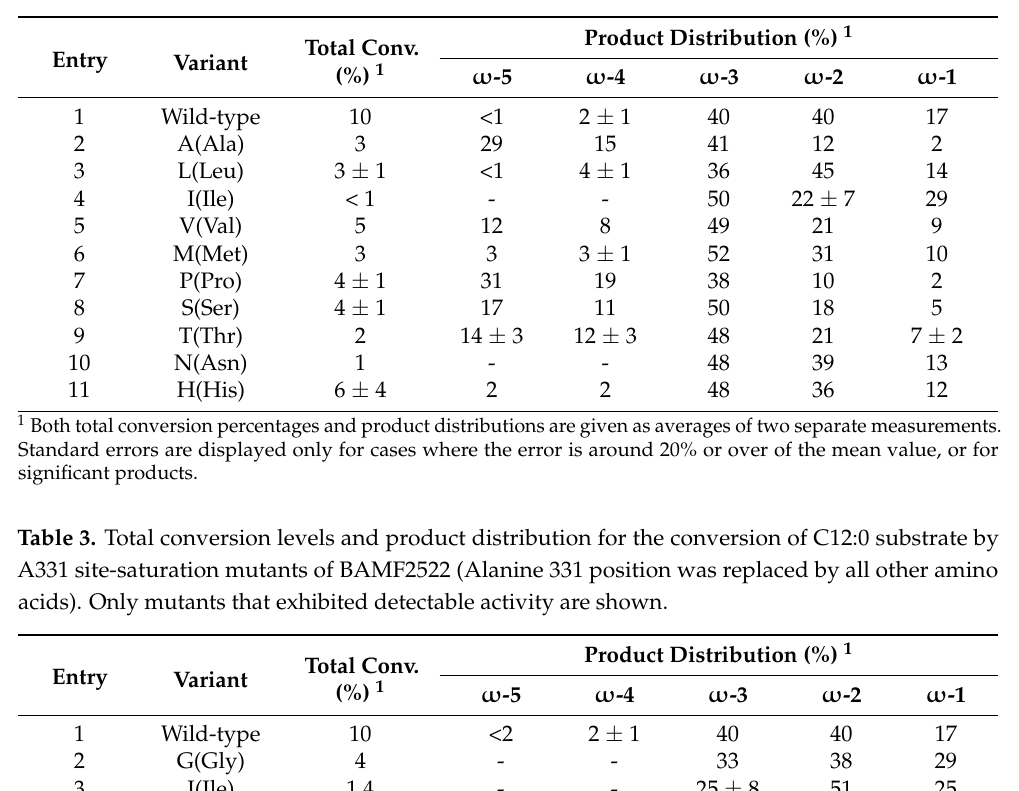
Table 2. Total conversion levels and product distribution for the conversion of C12:0 substrate by F89 site-saturation mutants of BAMF2522 (Phenylalanine 89 position was replaced by all other amino acids). Only mutants that exhibited detectable activity are shown. Total Conv. Entry Variant (%) 1